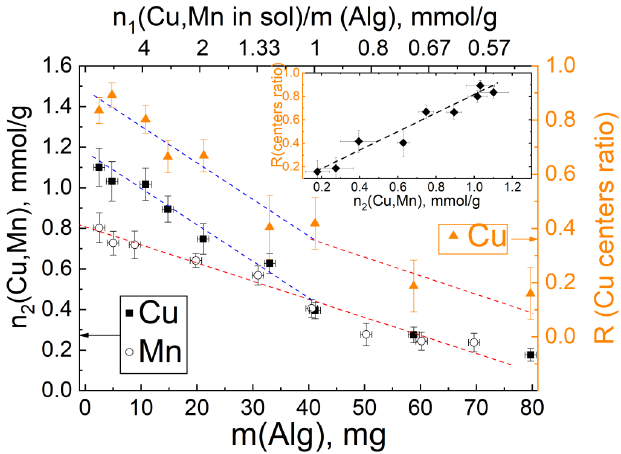
Figure 7. EPR spectra of Cu 2+ ( A ) and Mn 2+ ( B ) ions. 1—the EPR spectra of Cu(NO 3 ) 2 or Mn(CH 3 COO) 2 solutions with a concentration of 102.5 mmol/L. 2—the EPR spectra of Cu 2+ and Mn 2+ ions in the alginate when the number of these ions is insufficient for complete cross-linking. 3—the EPR spectra of Cu 2+ and Mn 2+ ions in the alginate at an excess amount of these ions in the solution. The dashed lines show the modeling spectra.